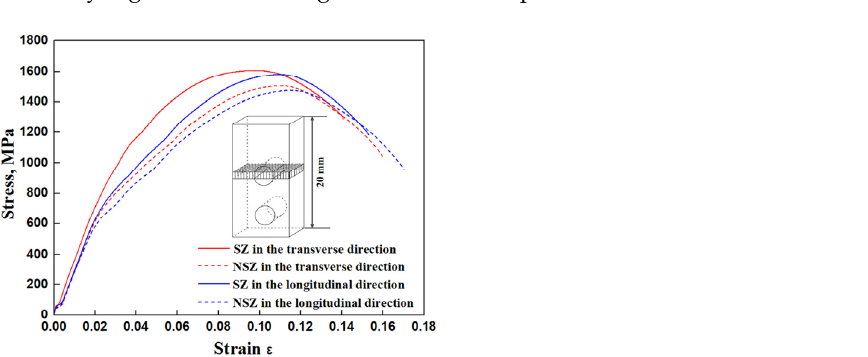
Table 1. Tensile properties of the NM450 steel specimens in different directions.